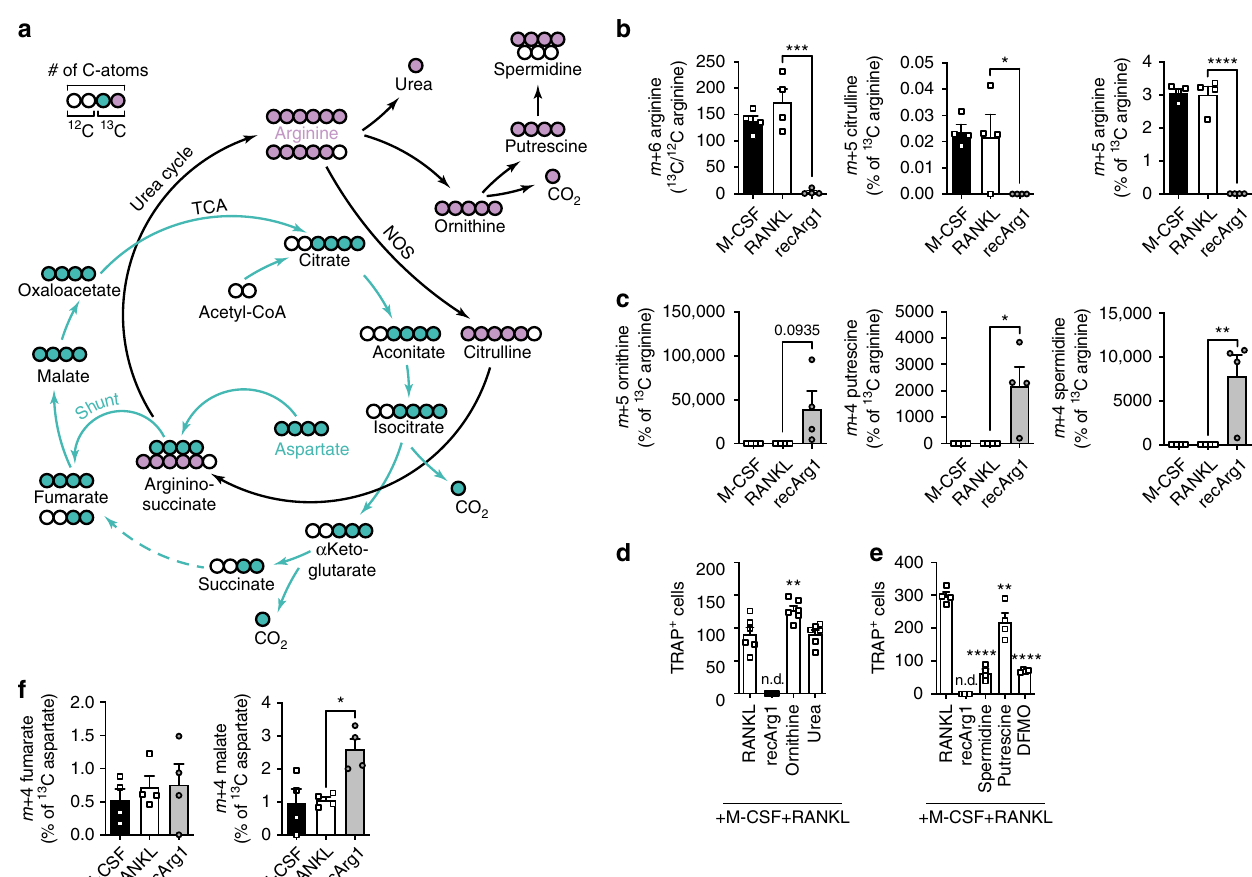
Fig. 5 Metabolic tracing of arginine and aspartate reveal arginine withdrawal instigates a dysregulated TCA cycle. a Schematic of the fate of the 13 C- labelled atoms deriving from arginine (pink) or aspartate (turquoise). b Ratio of intracellular 13 C 6 -labelled arginine to unlabelled 12 C 6 arginine pool and percent m + 5 citrulline and m + 5 arginine normalized to the labelled 13 C 6 arginine pool ( n = 4). c Intracellular m + 5 ornithine, m + 4 putrescine and m + 4 spermidine normalized to 13 C 6 -labelled arginine input ( n = 4). d Excess of recArg1 degradation products ornithine and urea do not impact osteoclastogenesis ( n = 6). e Effect of extracellular polyamines and polyamine synthesis inhibitor di fl uoromethylornithine (DFMO) on osteoclastogenesis ( n = 4). f Intracellular m + 4 fumarate and m + 4 malate normalized to 13 C 4 -labelled aspartate input ( n = 4). Data are mean ± SEM, * P < 0.05, ** P < 0.01, *** P < 0.001, **** P < 0.0001, one-way ANOVA post-hoc pairwise comparisons with Bonferroni correction ( b – f ). Source data are provided as a Source Data fi